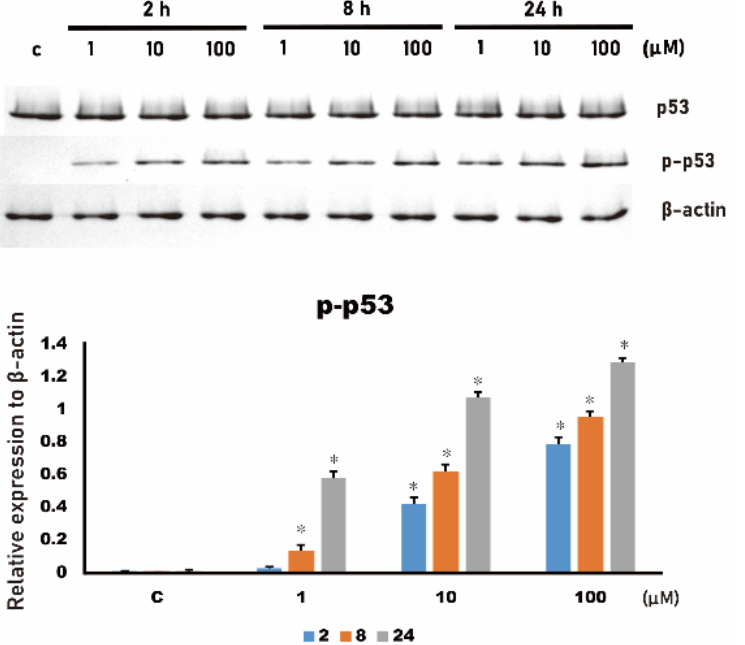
Figure 1. The change in p-p53 expression levels upon 4HR treatment in YD-15 cells. When compared to the untreated control, 4HR treatment increased p-p53 expression levels significantly (* p < 0.05 by Bonferroni test).